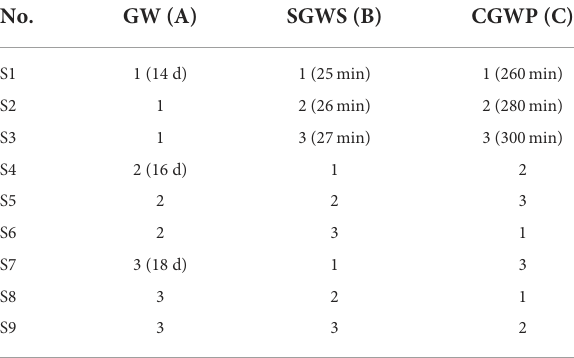
TABLE 1 Factors and levels of orthogonal test.